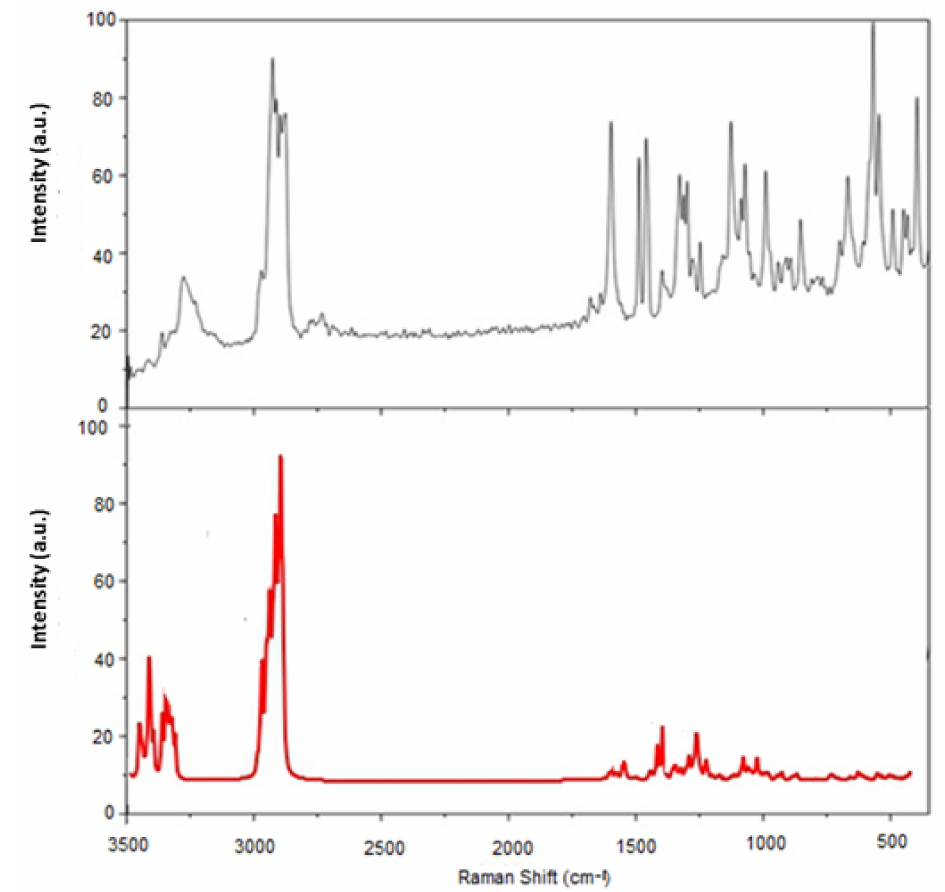
Figure 7. FT-Raman experimental spectrum of [Cu(Citr) 2 ] n in the region 3500–450 cm − 1 (black line) and FT-Raman calculated spectrum at the level of theory mPW1PW91/6-31G(d)-LANL2DZ and ECP=LANL2DZ (red line). Table 6. FT-Raman experimental and calculated vibrational frequencies of [Cu(Citr) 2 ] n obtained at the level of theory mPW1PW91/6-31G(d)-LANL2DZ and ECP=LANL2DZ. Experimental mPW1PW91